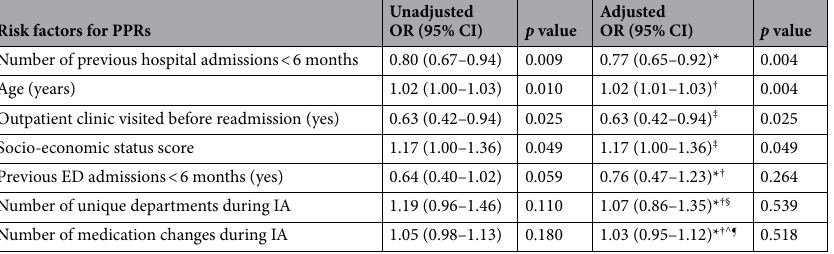
Table 3. Univariable and multivariable association among potential risk factors and potentially preventable readmission (PPRs). ED = Emergency Department, IA = initial admission, SES = Socio-economic status. Adjusted for: * = age; † = Previous hospital admissions < 6 months; ^ = SES score; ¶ = Number of unique departments during IA; § = Number of medication changes during IA; ‡ = Unadjusted analysis, no confounding factors found during step-wise